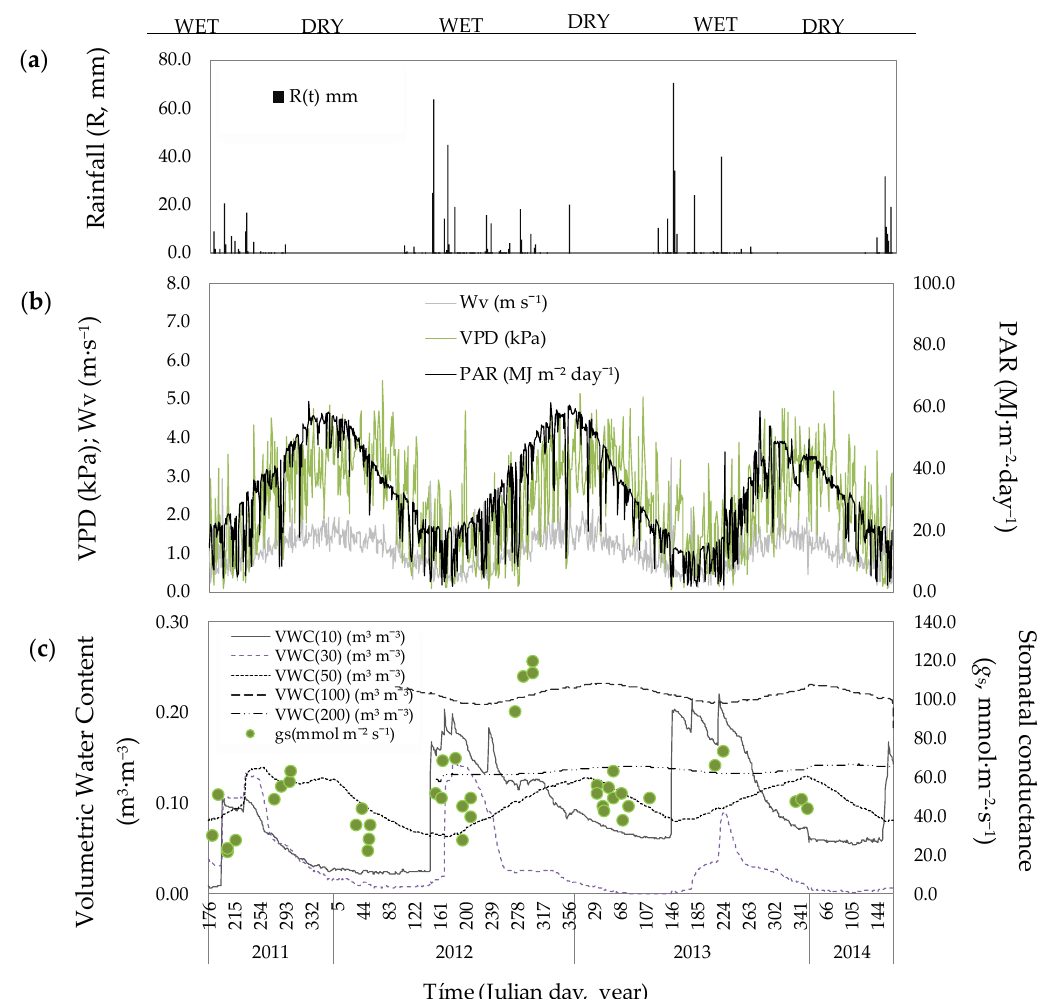
Figure 4. ( a ) Rainfall (R, mm); ( b ) atmospheric variables ( n = 1042 days): wind velocity ( W v , m · s − 1 ); vapor pressure deficit (VPD, kPa) and photosynthetically active radiation (PAR, W · m − 2 ); ( c ) daily average ( n = 1042 days) for VWC (m 3 · m − 3 ) at different soil depths (cm): 10, 30, 50, 100 and 200 cm, and leaf stomatal conductance daily average (mmol · m 2 · s − 1 ) for n = 42 days with records. Julian day is shown in the x-axis considering day 1 being January 1st of every year.